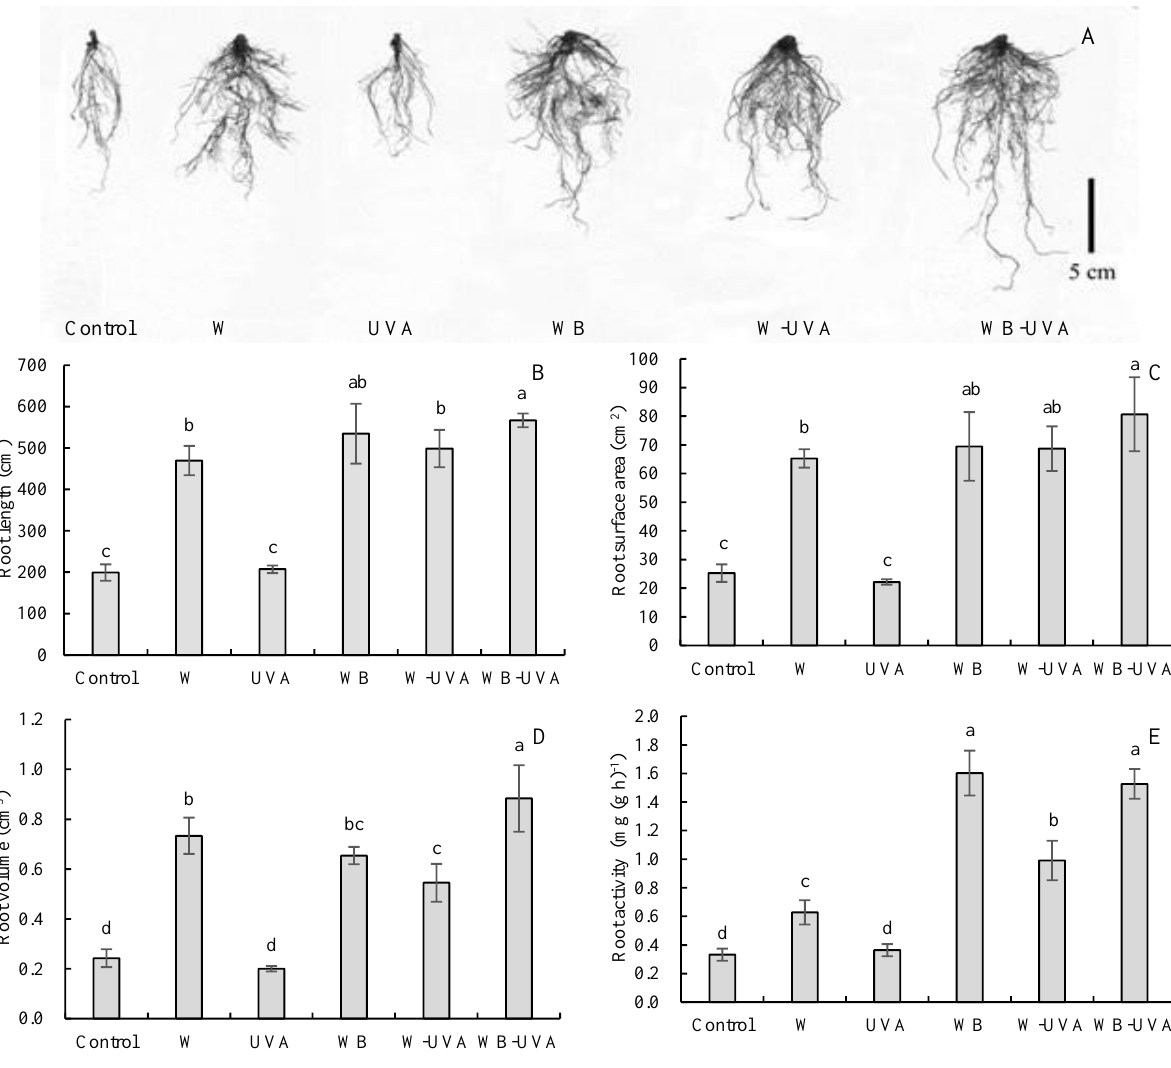
Figure 1. Effects of supplementary light provided by white (W), UV-A light-emitting diodes (LEDs), and various combinations of W, blue (B), and UV-A LEDs on root morphology ( A ), root length ( B ), root surface area ( C ), root volume ( D ), and root activity ( E ) of greenhouse-grown cucumber seedlings cultivated for 22 days after sowing; cucumber seedlings grown without supplementary light were used as control. Different letters within each parameter were significantly different tested by the least significant difference (LSD) test at p < 0.05.